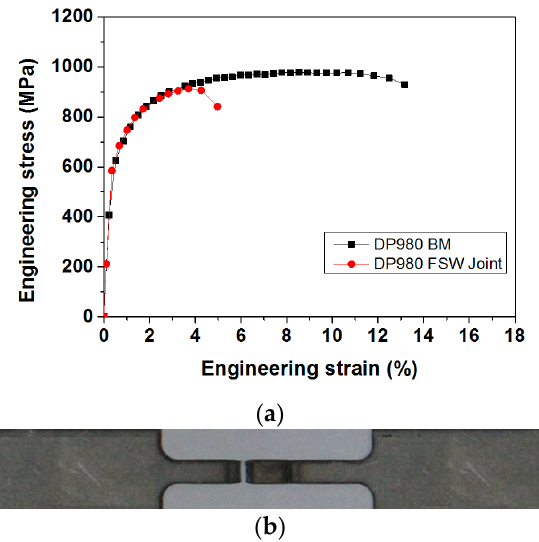
Figure 6. Results for tensile tests of DP980 FSW: ( a ) Engineering stress ‐ strain curve; ( b ) a typical failed sample after tensile test.